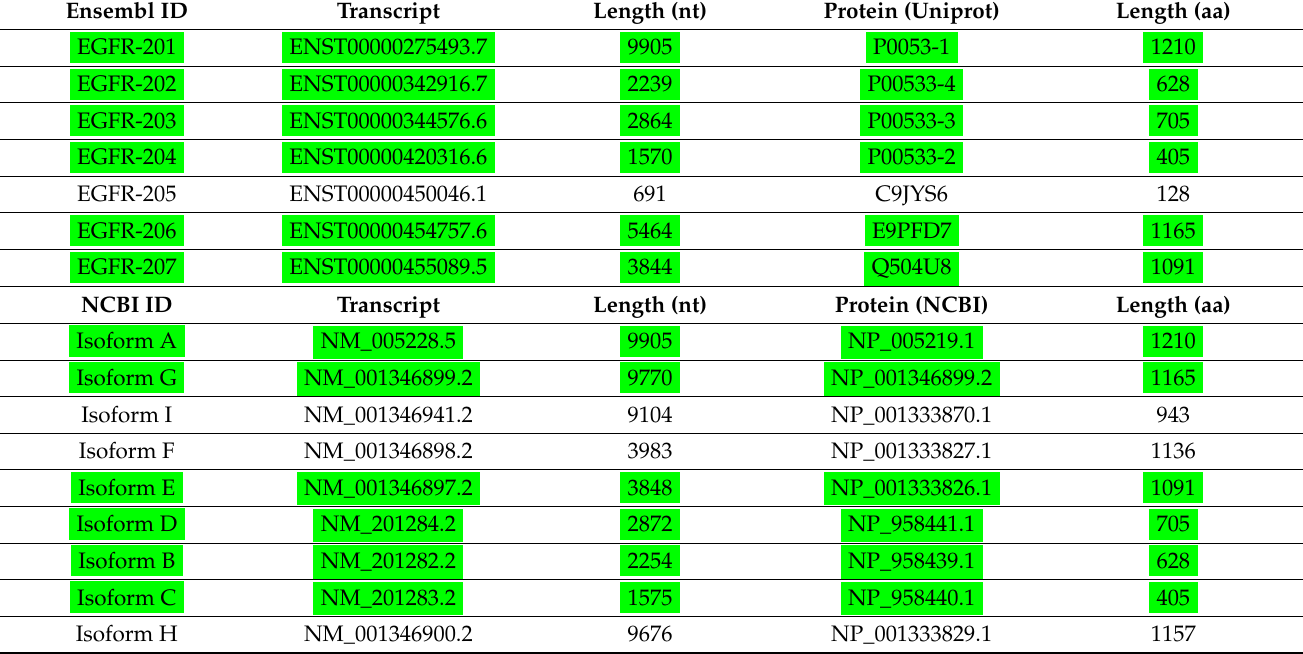
Table 2. List of human EGFR isoforms in the Ensembl and NCBI genomic databases. ID, transcript name, transcript length, protein name and protein length for all human EGFR isoforms listed in the Ensembl (top) and NCBI (bottom) databases. Isoforms highlighted in green are common to both